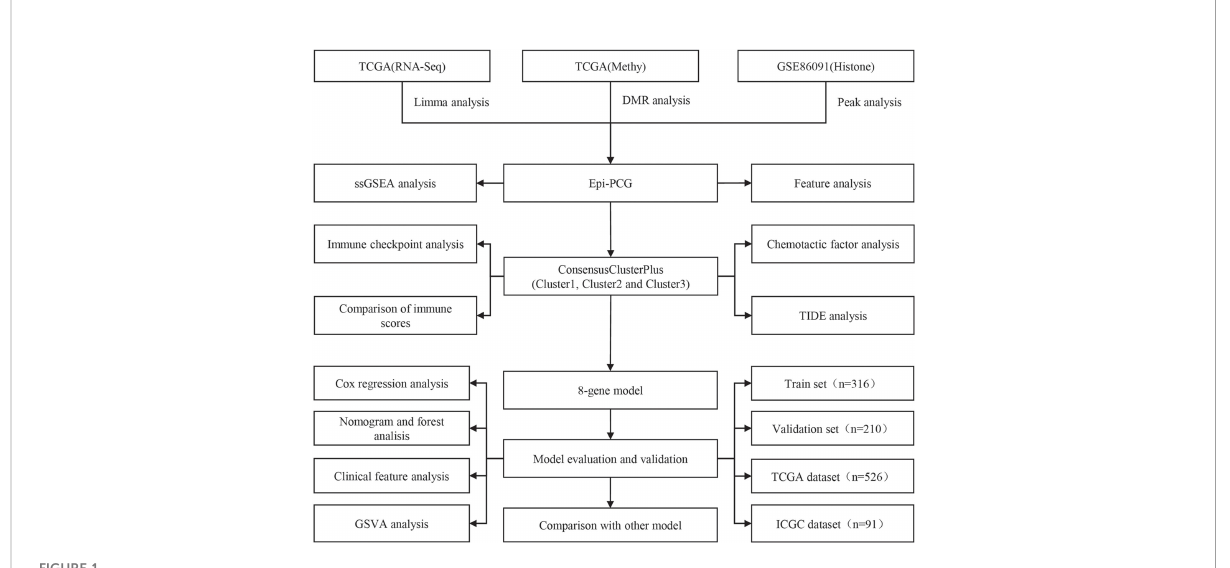
FIGURE 1 The work fl ow of this